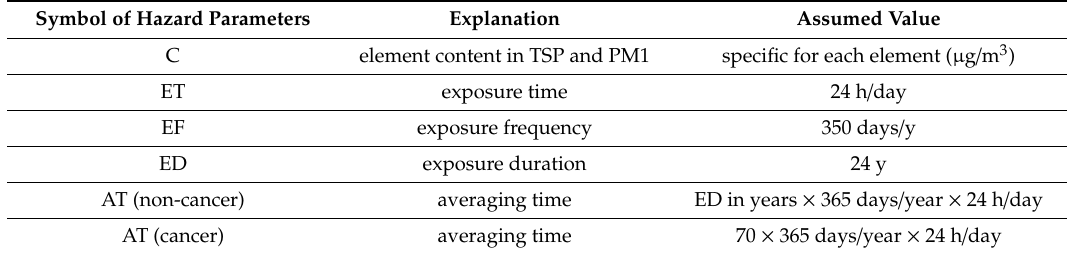
Table 1. Hazard parameters used for calculating the inhalable chemical (EC)